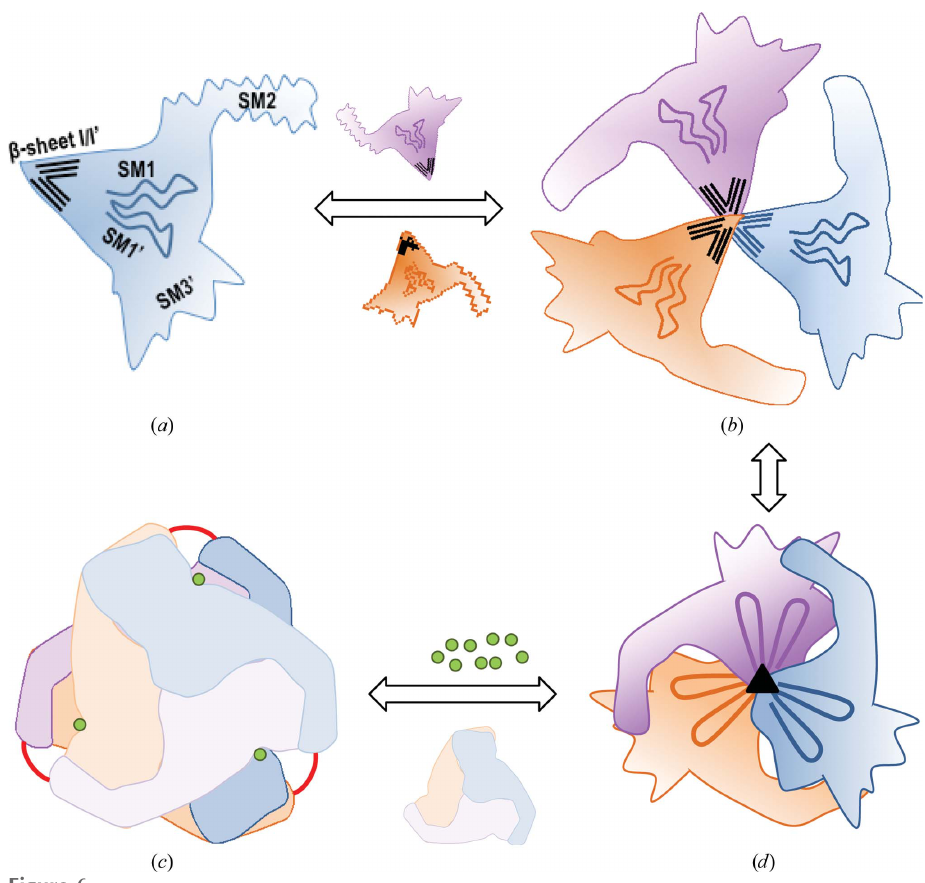
Figure 6 Proposed model for canonical hexamer assembly. Individual monomers ( a ) start to nucleate a protomer via (cid:3) -sheets I/I 0 ( b ). Next, the SM1/1 0 and SM2/SM2 0 flexible regions from (cid:3) -sheets II/II 0 are stabilized in the nascent protomer, resulting in favoured additional intersubunit interactions within the protomer ( c ). Final stabilization is attained with the proper folding of SM3 0 and of the Cl A and Cl B motifs that allow the binding of chloride ions (green spheres) ( d ). The two protomers in the hexamer are now ready to be joined by sulfilimine bonds (red